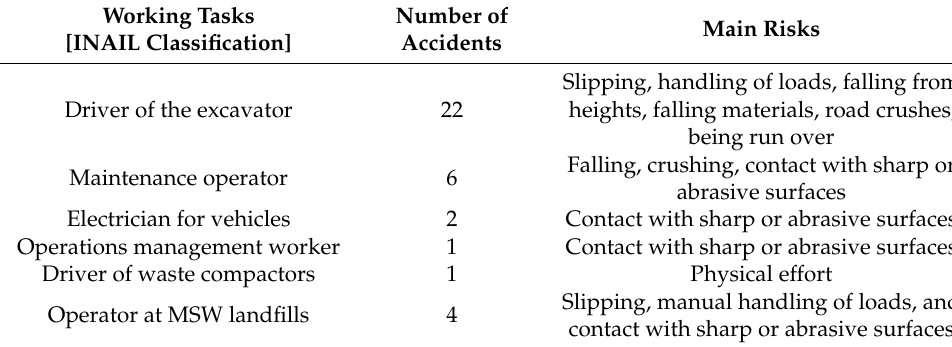
Table 9. Main risks due to the work equipment misuse.